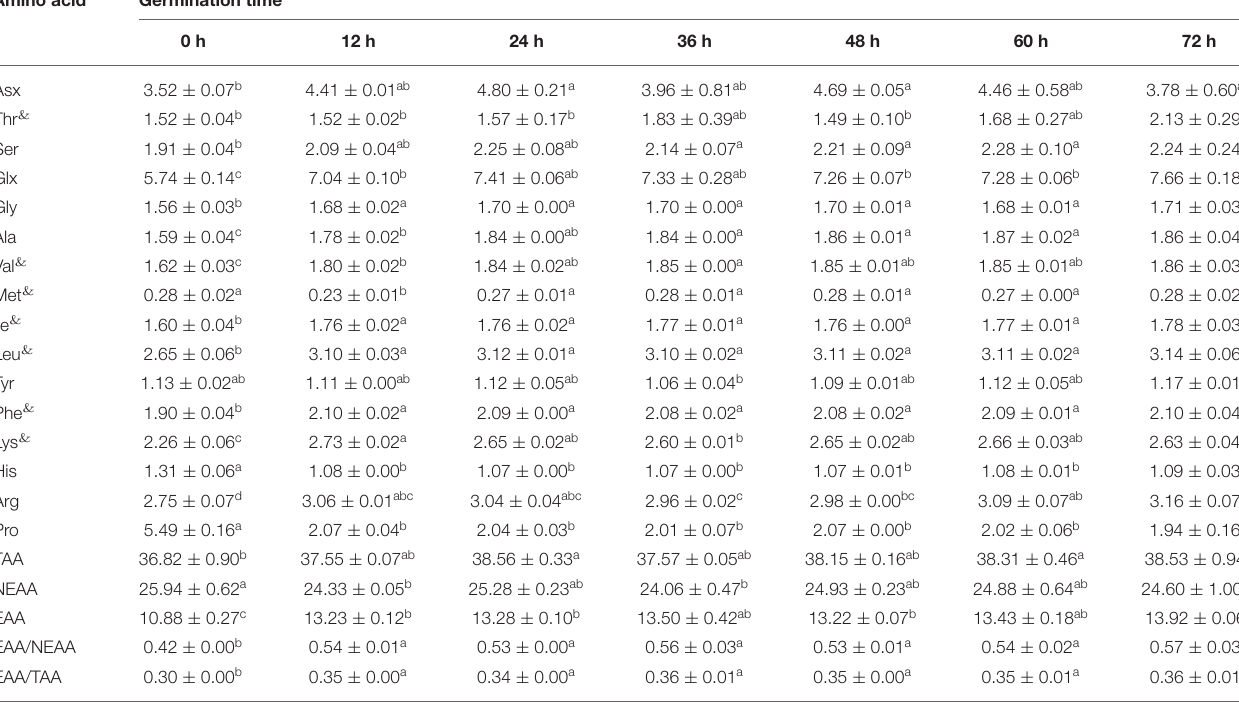
TABLE 2 | The amino acid content in soybean with different germination time (in dry matter, g/100g). Amino